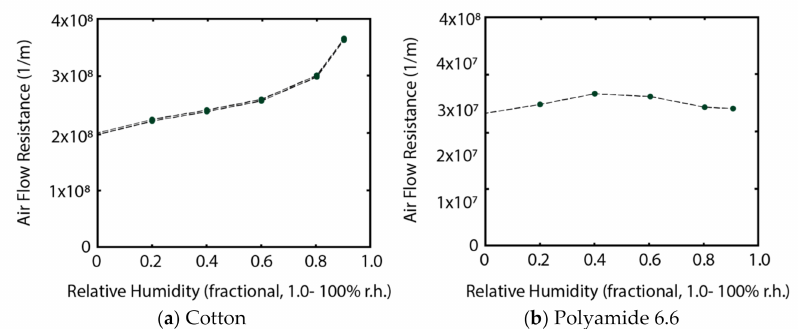
Figure 10. Results from cotton and nylon samples tested using by Phil Gibson, US Army Natick Soldier Systems, Natick. ( a ). 100% Cotton. Weight: 150 g / m 2 , source: Paolo Gilli, cira: Spring / Summer 2004 reference: Sirena, Width: 148–150 cm ( b ). 100% Polyamide 6.6 Weight: 83g / m 2 , source: William Reed, circa: 2001, reference: 131980, width: 155